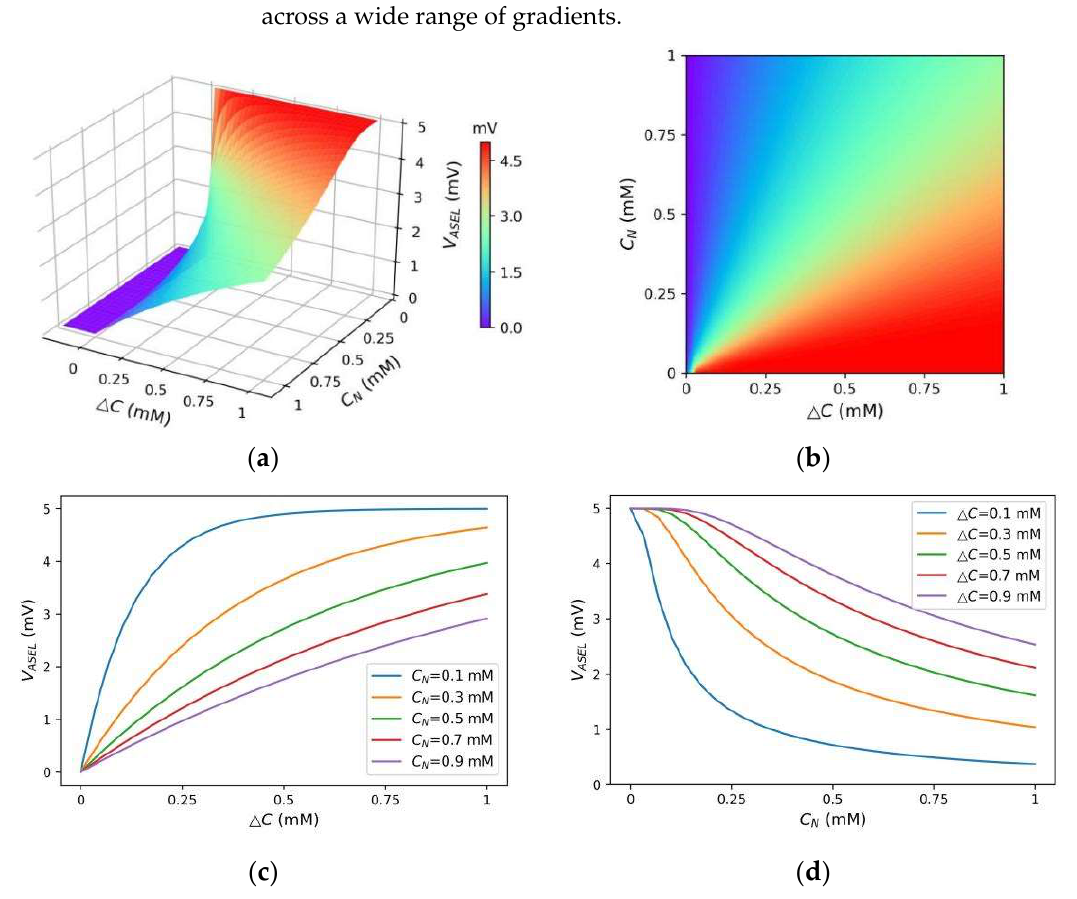
Figure 10. ( a ) ASEL voltage peak as function of concentration difference Δ C ( t ) and historical average absolute concentration difference C N ( t ); ( b ) top view of ( a ); ( c ) variation tendency of ASEL voltage peak with the change of C t ; and ( d ) variation tendency of ASEL voltage peak with the change of C t . N